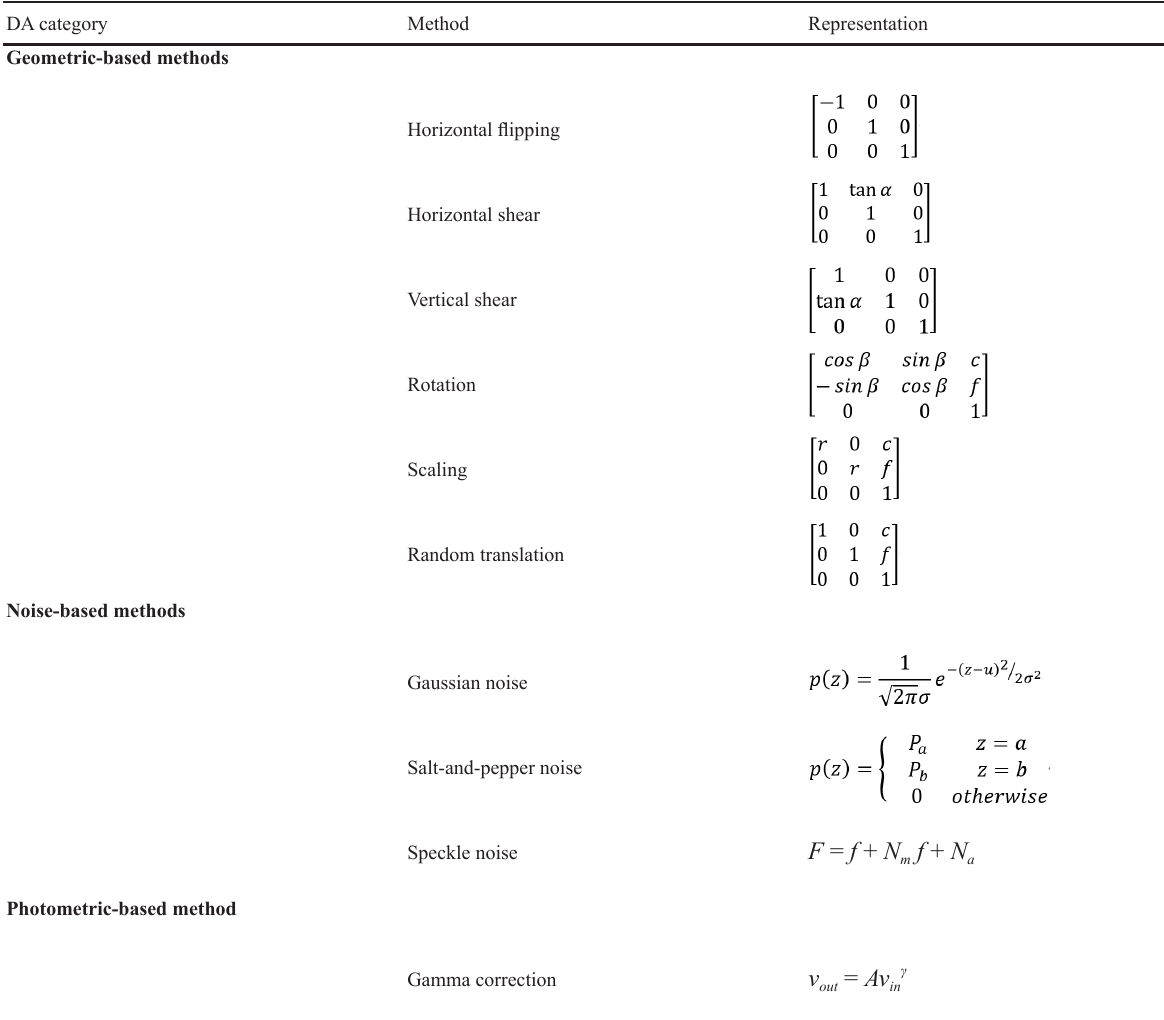
Table 5. 18-way data augmentation.